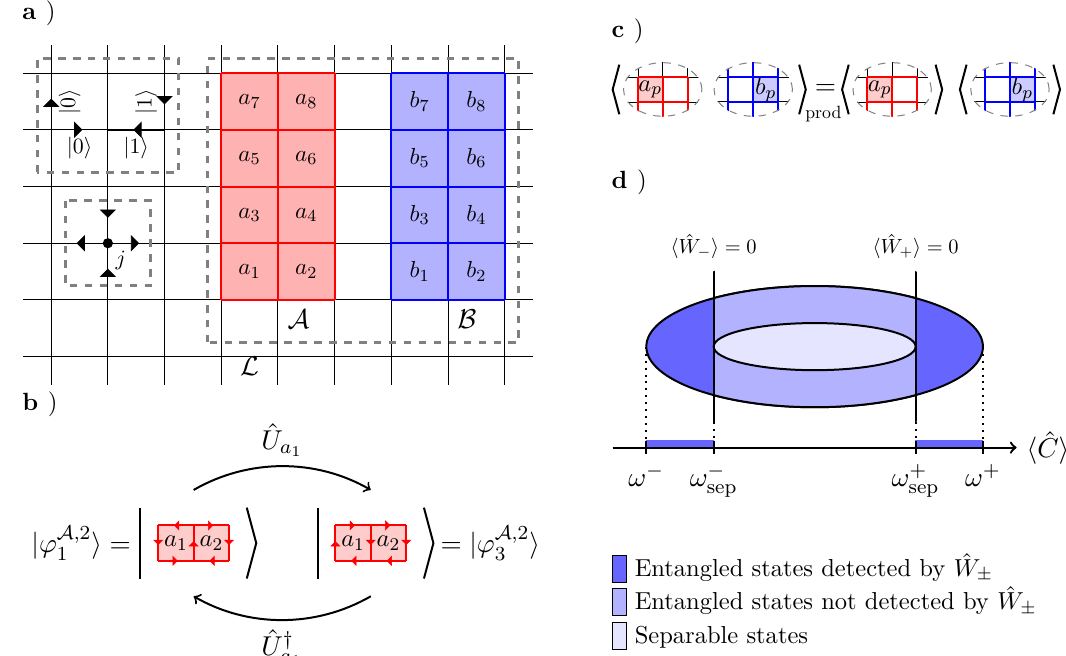
Figure 1. Entanglement witnessing in lattice gauge theories. a) Lattice used for the examples in this work. Top left: basis choice for the two-dimensional Hilbert space associated with the electric field living on edges. Bottom left: physical states obey a local gauge symmetry, here exemplified for a U(1) pure gauge theory. At all vertices j , adjacent electric fields have to sum up to zero ( two-in-two-out rule ). Right: example of disjoint subregions A and B for which entanglement witnesses are constructed in this work ( a p and b p label plaquettes). b) The expectation value